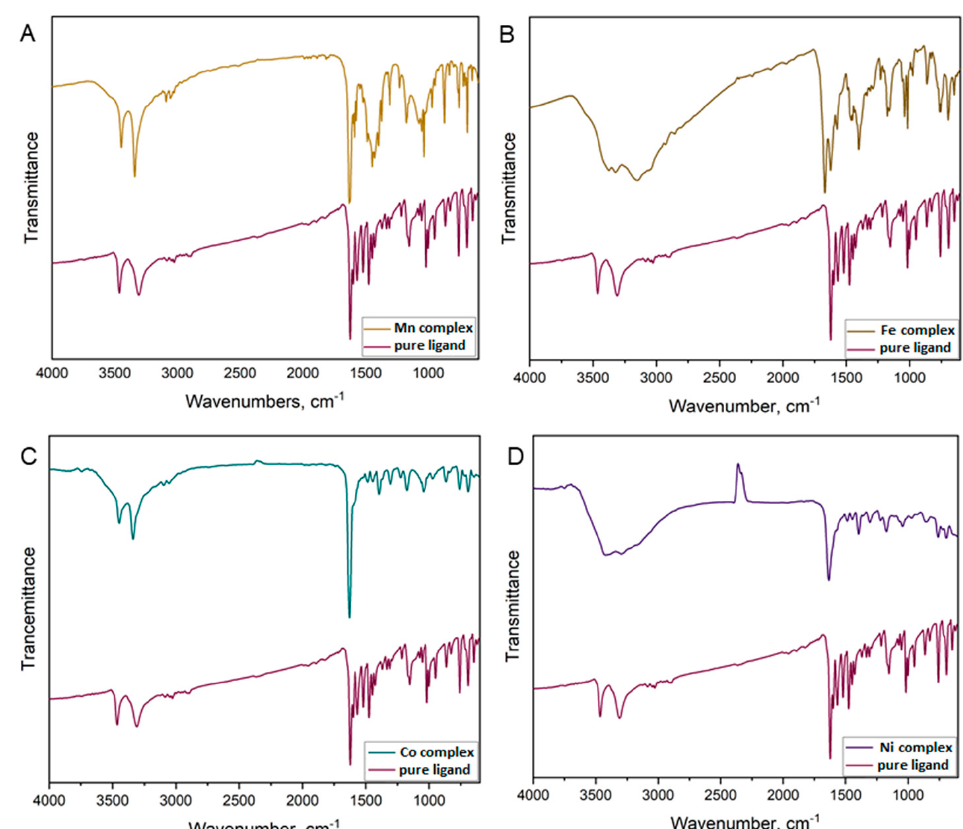
Figure 4. FTIR spectra of pure ligand and obtained complexes of ( A ) Mn(II); ( B ) Fe(III); ( C ) Co(II); and ( D ) Ni(II).